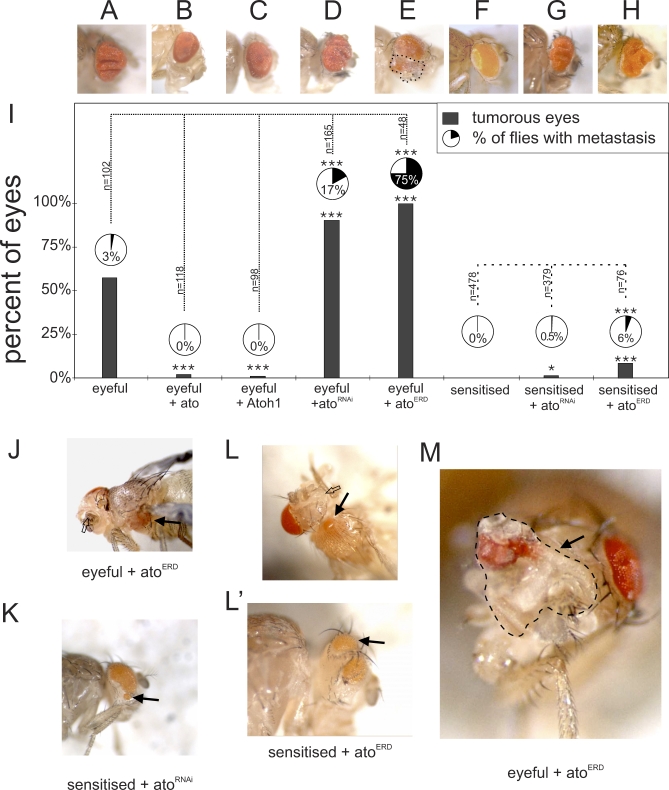

atonal Gain and Loss of Function Suppress and Promote Tumor Formation, Respectively, in a Drosophila Cancer Paradigm(A–I) Qualitative and quantitative representation of the tumor burden in different genotypes. Each lane is a separate genotype. Gray bars show percentage of tumorous eyes, pie charts show metastasis incidence. (A) ey-GAL4, UAS-Dl, eyeful/+ fly (“+” = wild-type chromosome). (B and C) Gain of ato function suppresses tumor formation. (B) ey-GAL4, UAS-Dl, eyeful/UAS-ato. (C) ey-GAL4, UAS-Dl, eyeful/UAS-Atoh1. (D and E) Loss of ato function enhances tumor burden. (D) ey-GAL4, UAS-Dl, eyeful/+; UAS-atoRNAi/+. (E) ey-GAL4, UAS-Dl, eyeful/UAS-atoERD. Dotted line indicates undifferentiated overgrowth of the eye tumor. (F) A sensitized genotype with eye-specific Dl overexpression leading to mild eye overgrowth: ey-Gal4, UAS-Dl/+. (G and H) Loss of ato function can initiate tumor formation. (G) ey-Gal4, UAS-Dl/+, UAS-atoRNAi/+. (H) ey-Gal, UAS-Dl/UAS-atoERD.(I) Graph showing quantification of the tumor burden in the different genotypes. Dotted lines show the comparison used for statistical analysis. A single asterisk (*) indicates p < 0.05; triple asterisks (***) indicate p < 0.001 as analyzed by the chi-square test, and ‘n' represents number of flies analyzed.(J and K) Examples of metastasis and loss of differentiated eye tissue in eyeful and sensitized flies upon loss of ato function. (J) ey-GAL4, UAS-Dl, eyeful/UAS-atoERD: black arrow shows metastasis, open arrow shows loss of differentiated eye tissue. (K) ey-Gal4, UAS-Dl/+, UAS-atoRNAi/+ with metastasis on the head.(L and L′) ey-Gal, UAS-Dl/UAS-atoERD showing metastasis in the thorax (black arrows) and on the head and loss of differentiated retina (open arrow).(M) ey-Gal, UAS-Dl/UAS-atoERD showing a massive undifferentiated tumor (dotted line) on the fly head.